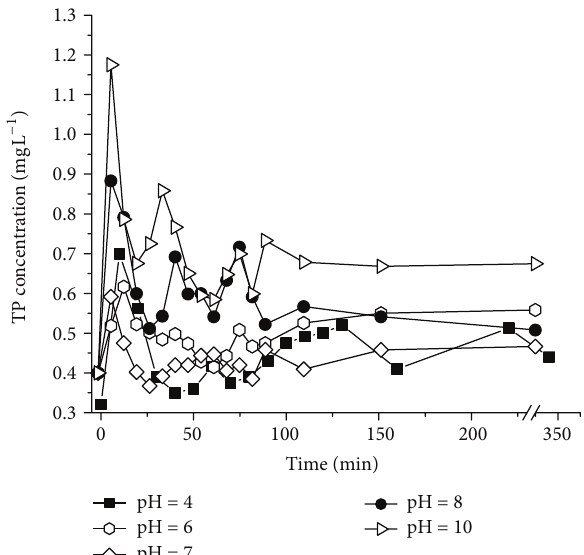
Figure1:ConcentrationchangesofTPinthepHeffectexperiments.